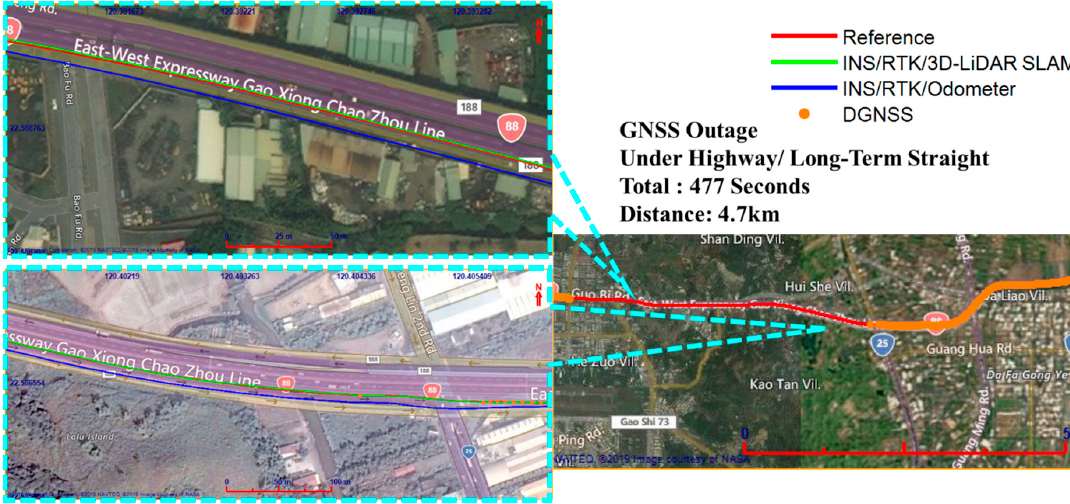
Figure 15. Scenario 2: zoomed area underneath the highway with long-term straight movement without a GNSS solution.